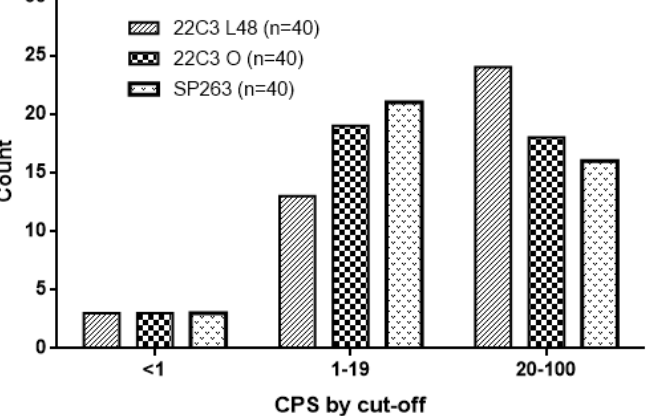
Figure 2. The figure shows the distribution of PD-L1 expression (as CPS) of the 22C3 pharmaDx, on Dako Autostainer link48 (L48) and Dako Omnis (O), and of SP263 assay for the different CPS cut- (<1; between 1 and 20 and offs (<1; between 1 and 20 and >20).